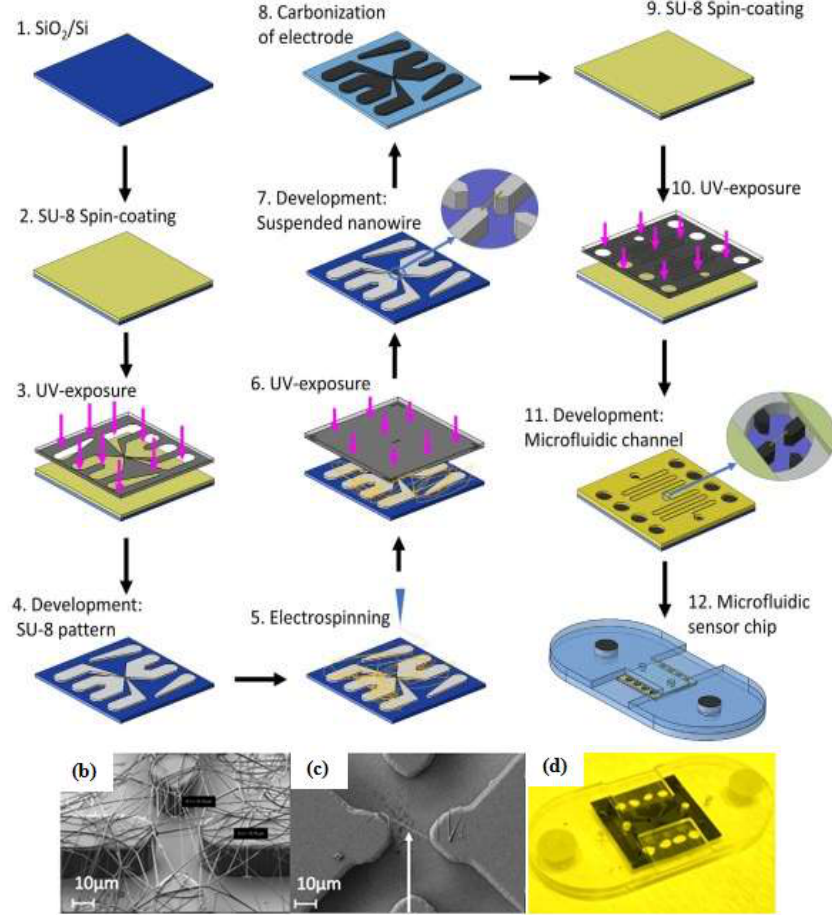
Figure 7. Fabrication steps of the carbon nanowire aptasensor. ( a ) The device was fabricated by